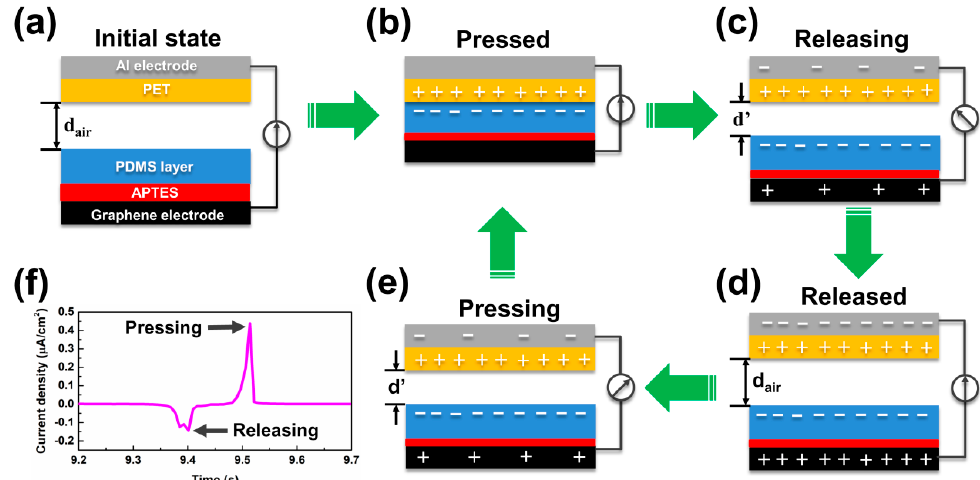
Figure 5. ( a ) Theoretical model, and ( b – e ) proposed charge generation mechanism of the developed TENG. ( f ) One cycle of the generated current output signal.